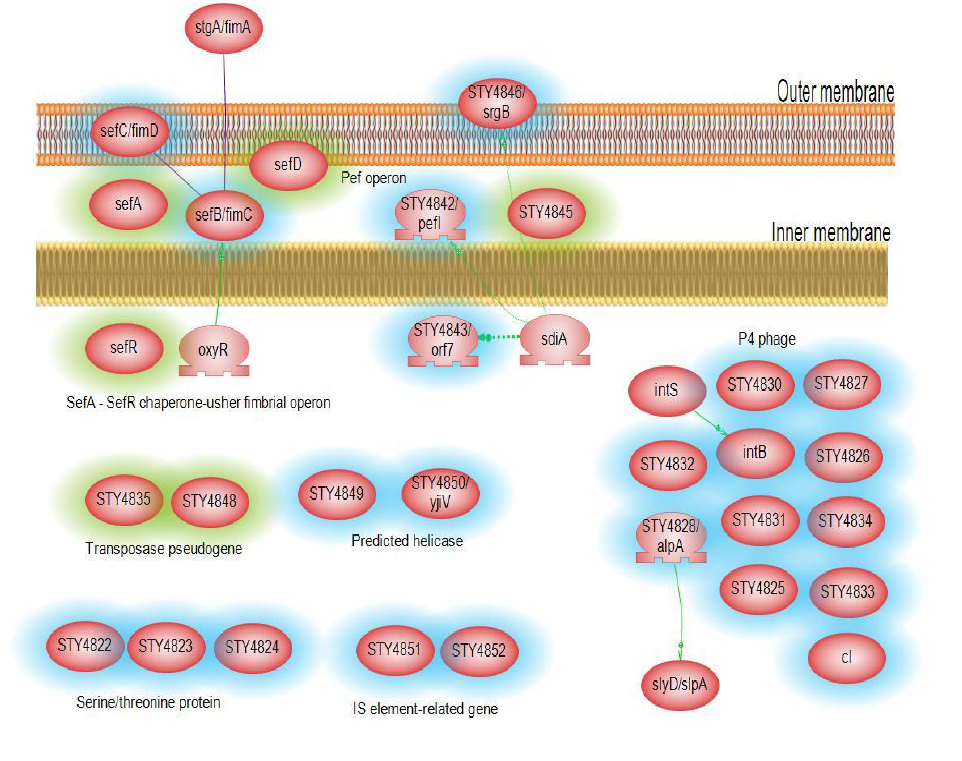
Figure 10 - SPI-10 proteins shown in pathway diagram form. SPI-10 is a hot spot for the insertion of transposable elements which played a major role in driving the variability of